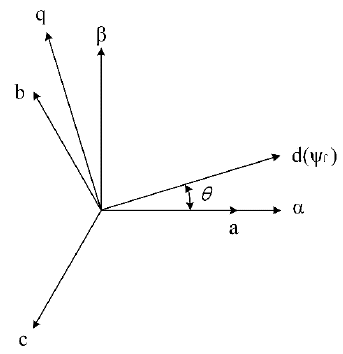
Figure 1. Working principle of the PMLSM.